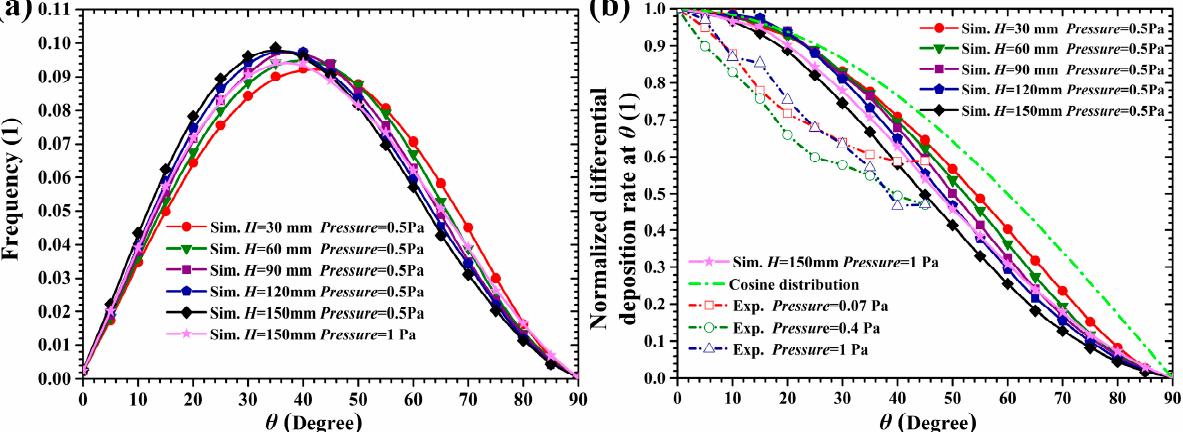
Figure 12. Incident angle distribution of sputtered Cu atoms under different target-substrate distances, ( a ) incident polar angle distribution; ( b ) normalized differential deposited rate as a function of polar angle obtained by simulation and experiment [38].